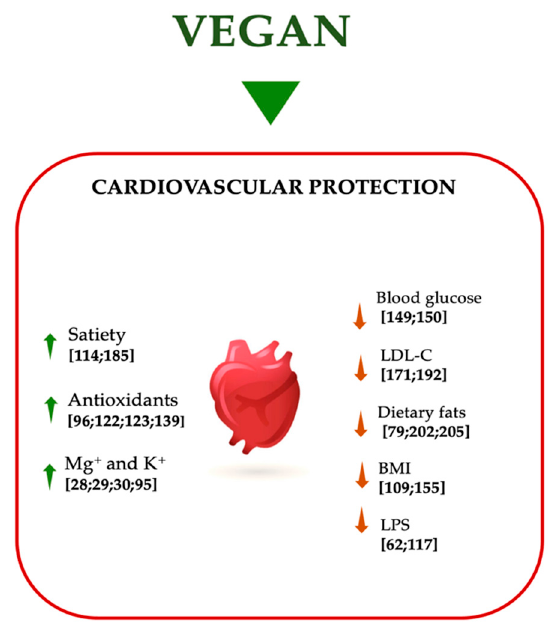
Figure 4. Effects of vegan diet on cardiovascular protection. Abbreviations: BMI, body mass index; K + , potassium; LDL-C, low-density lipoprotein-cholesterol; LPS, lipopolysaccharide; Mg + , magnesium; ↑ increase; ↓ decrease.